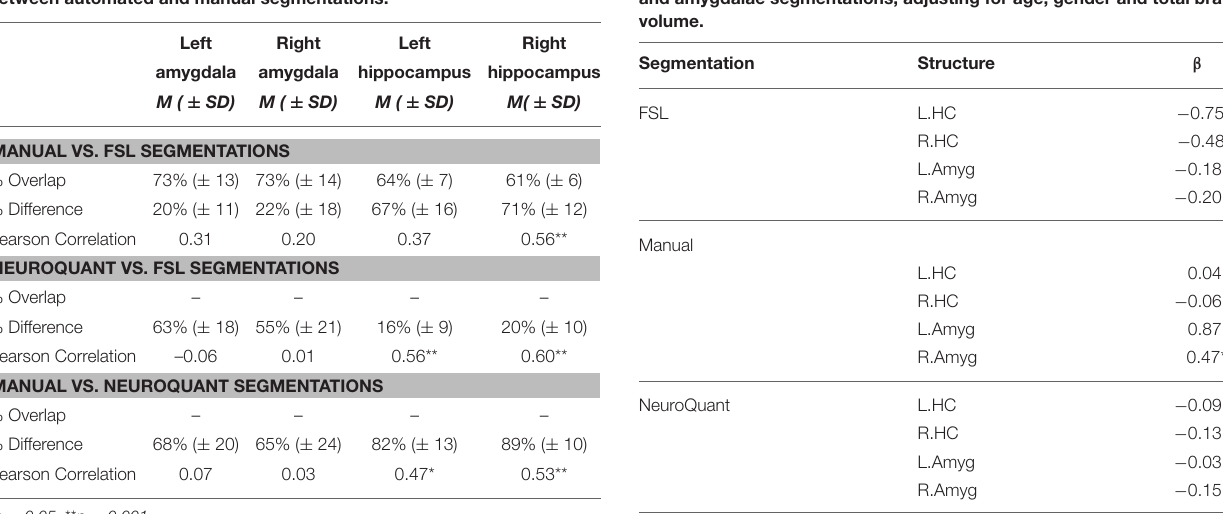
TABLE 2 | Summary of automated segmentation performance, percent volume overlap, percent volume difference, and Pearson’s correlations between automated and manual segmentations.